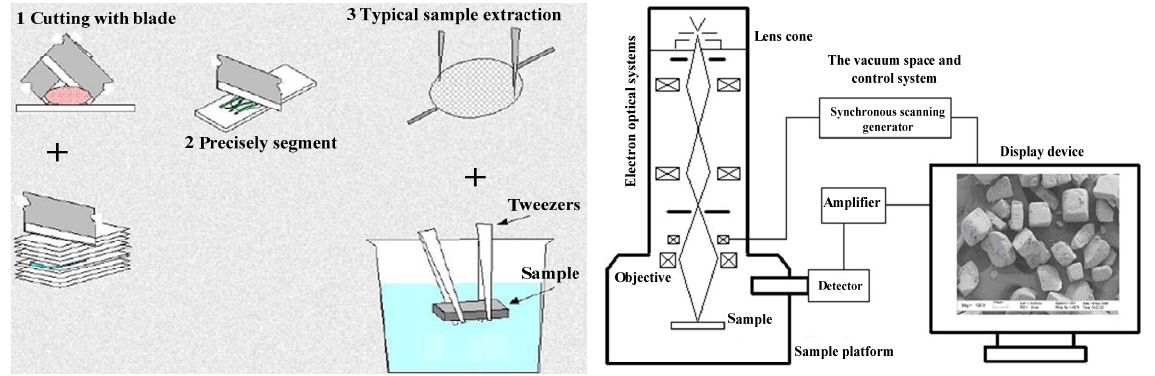
Figure 2. Sample preparation process and schematic diagram of the main components of the SEM.